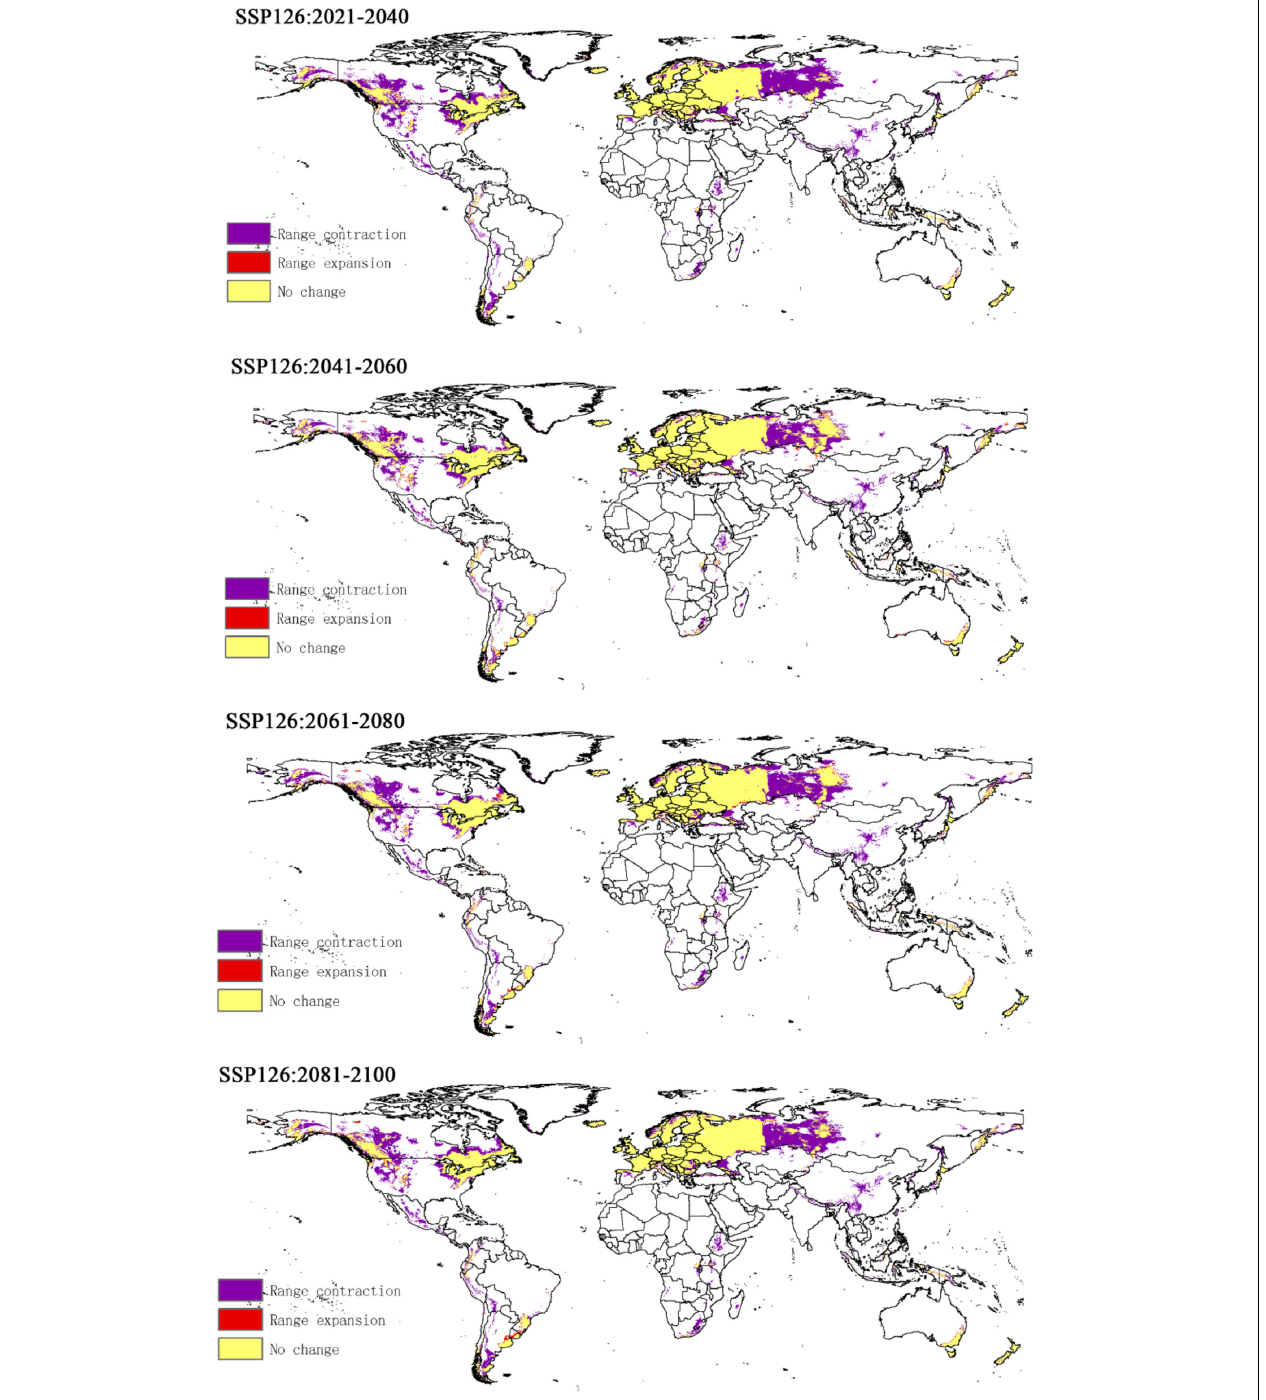
FIGURE 8 | The change of suitable distribution area of P. bidens under SSP126 climate scenario.